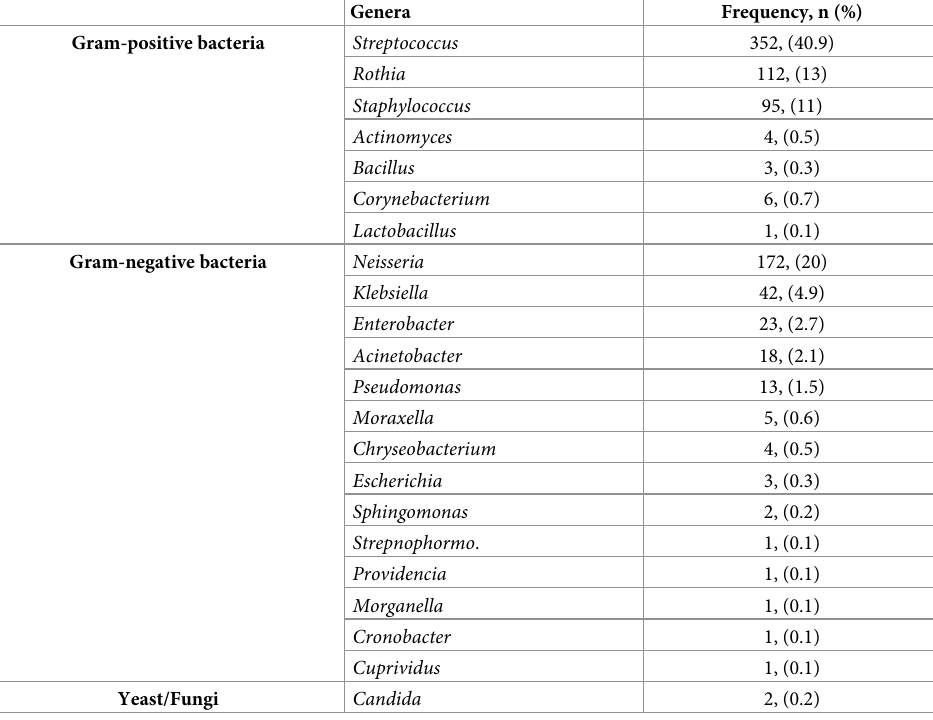
Table 5. Frequency of microorganisms isolated from acute pharyngitis